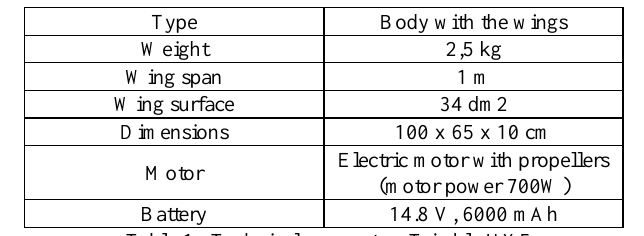
Table 1. Technical parameters Trimble UX5